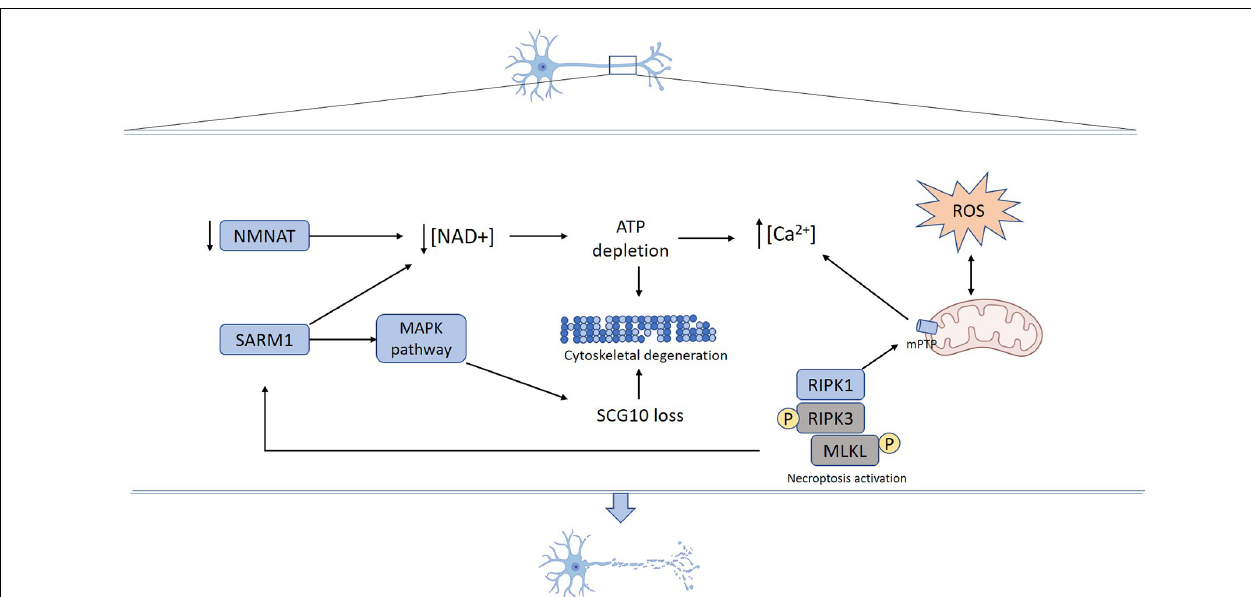
FIGURE 1 | Mechanisms underlying axon degeneration. Mechanical or toxic injury lead to nicotinamide mononucleotide adenylyltransferase (NMNAT) axonal loss and SARM1 activation resulting in NAD+ depletion. Activated SARM1 promotes NAD+ destruction and NMAT loss decreases NAD+ synthesis. Reduced axonal NAD+ levels lead to energy failure and ATP depletion. SARM1 also activates MAPK signaling pathways, which promotes SCG10 proteolysis. Increased reactive oxygen species (ROS) production promotes mPTP formation that also can be triggered by necroptosis activation. Energy failure derived from both NAD+ depletion and mitochondrial damage contributes to calcium unbalance, ROS production, and mPTP formation. Cumulative activation of mechanisms and structural damage ultimately result in cytoskeleton fragmentation and axon